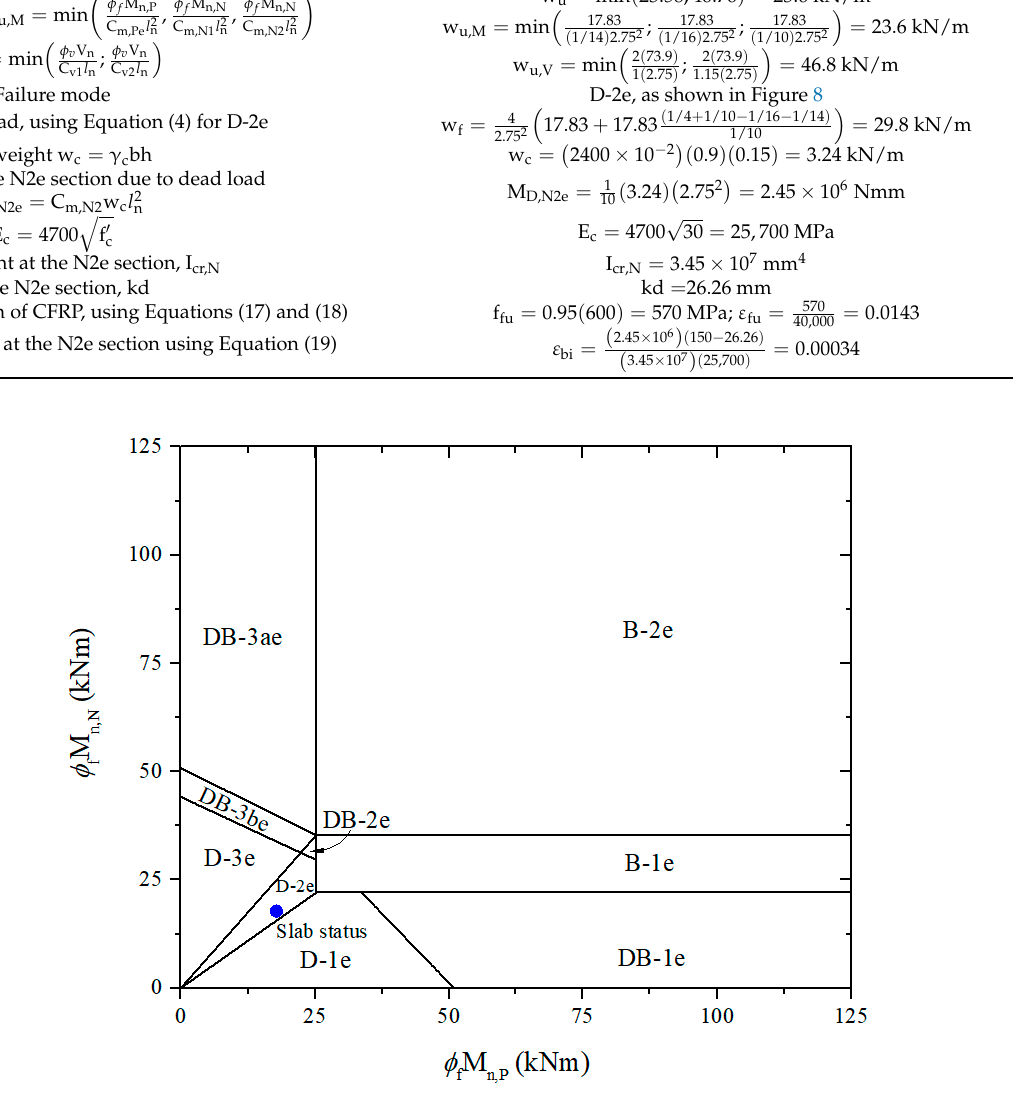
Figure 8. Establish failure limits and predict slab status based on moment carrying capacities for the control slab.